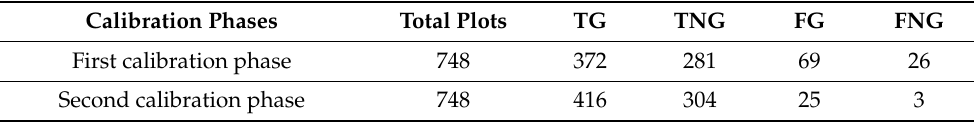
Table 3. Calibration performance after the first and second phases on the calibration data set. TG represents well-classified irrigated grassland polygons; FG, polygons classified as irrigated grassland while not an irrigated grassland; TNG, well classified not irrigated grassland polygons; FNG, irrigated grassland polygons classified as not irrigated